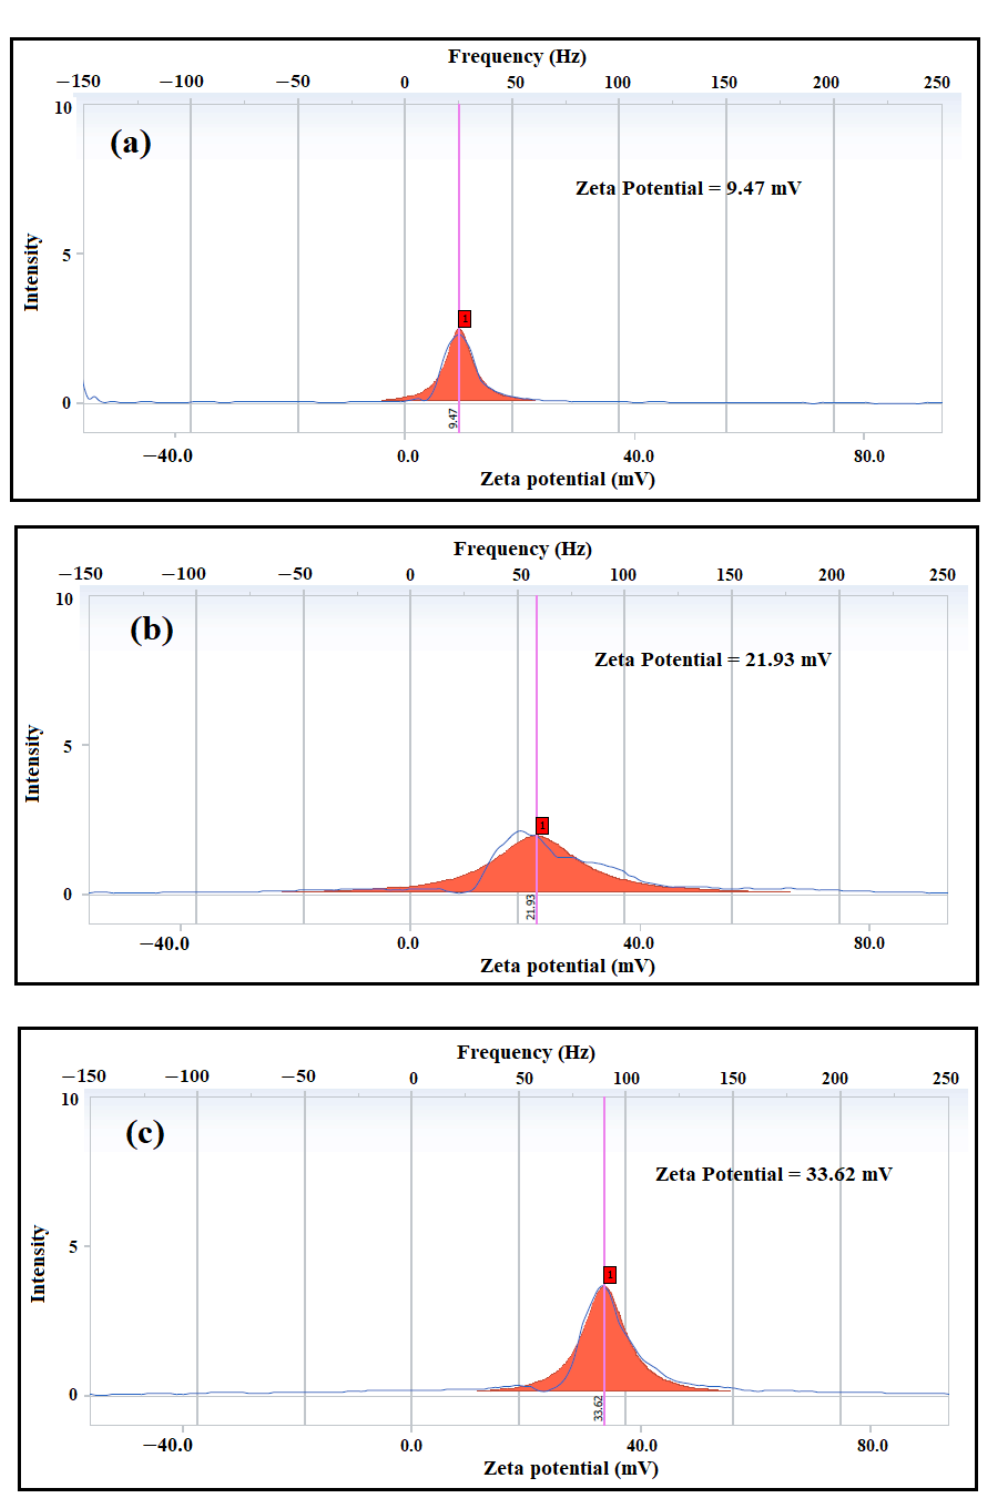
Figure 5. Zeta potential measurements of ( a ) QVP/MA-Fe 3 O 4 , ( b ) CQVP/MA, and ( c ) CQVP/MA- Fe 3 O 4